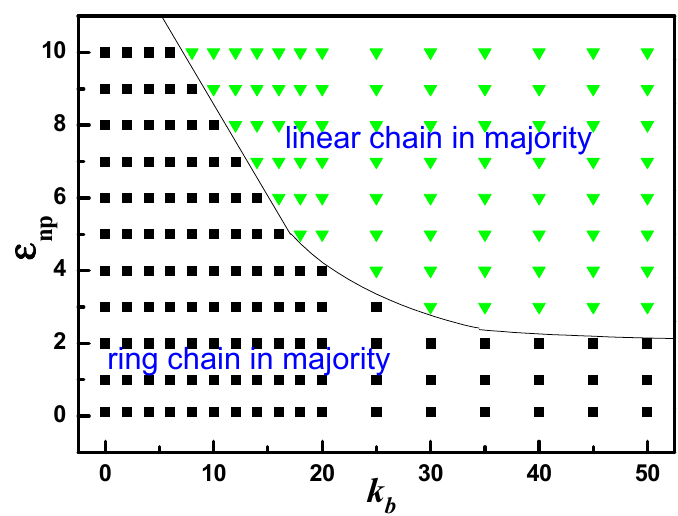
Figure 2. The phase diagram of ring and linear chains adsorbed to polymer-NP interfacial region as a function of polymer-NP interaction ε np and chain stiffness k b .